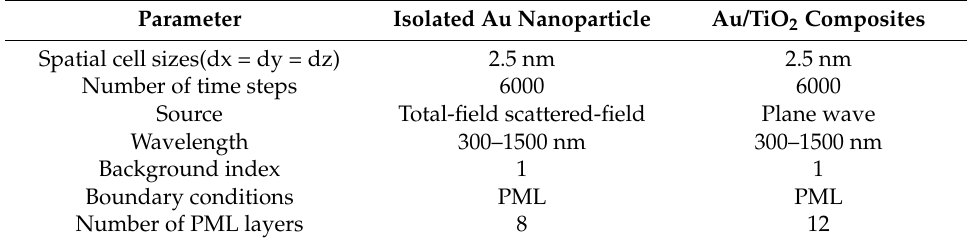
Table 2. FDTD parameter descriptions and settings to investigate the optical properties of the proposed Au-based